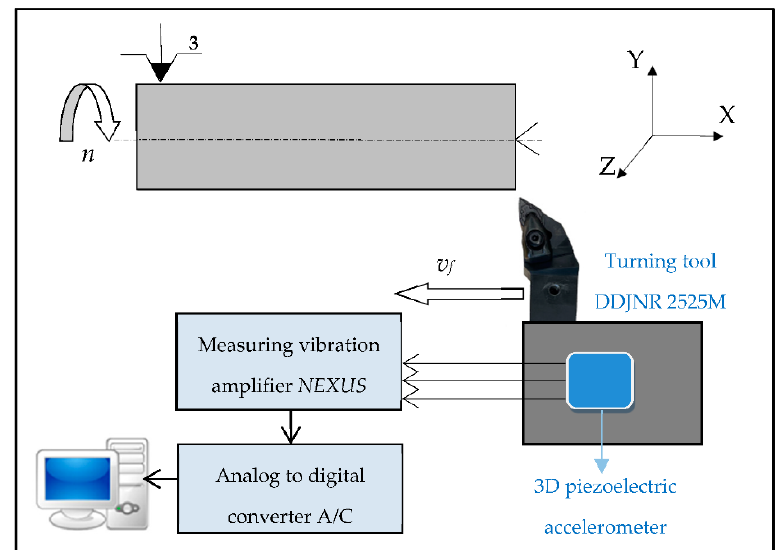
Figure 1. Scheme of experimental set up.